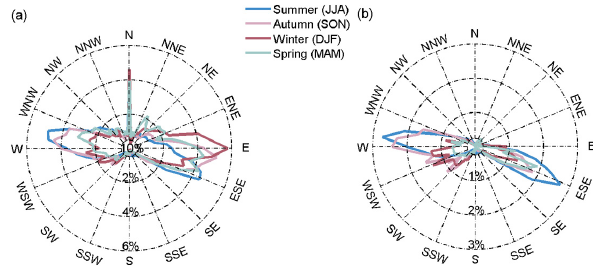
Figure 3. The frequency of wind direction plotted by wind rose for four seasons in Lhasa, (a) with all wind speed, the frequency of calm conditions is given in the center circle, (b) with wind speed above 2ms − 1